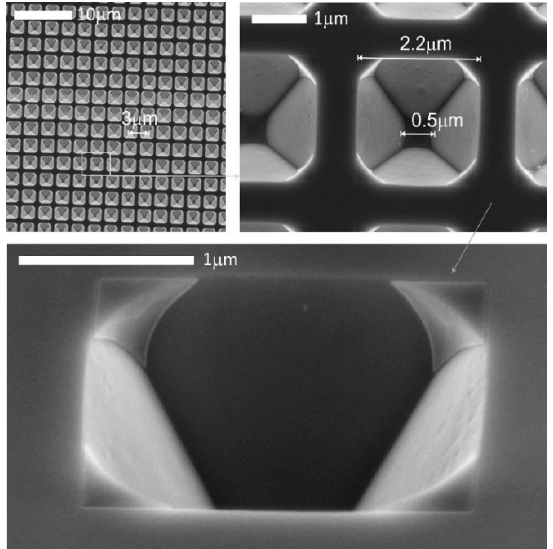
Figure 2. Scanning electron microscopy (SEM) image of the periodic perforated SERS substrate with dimensions of the voids.